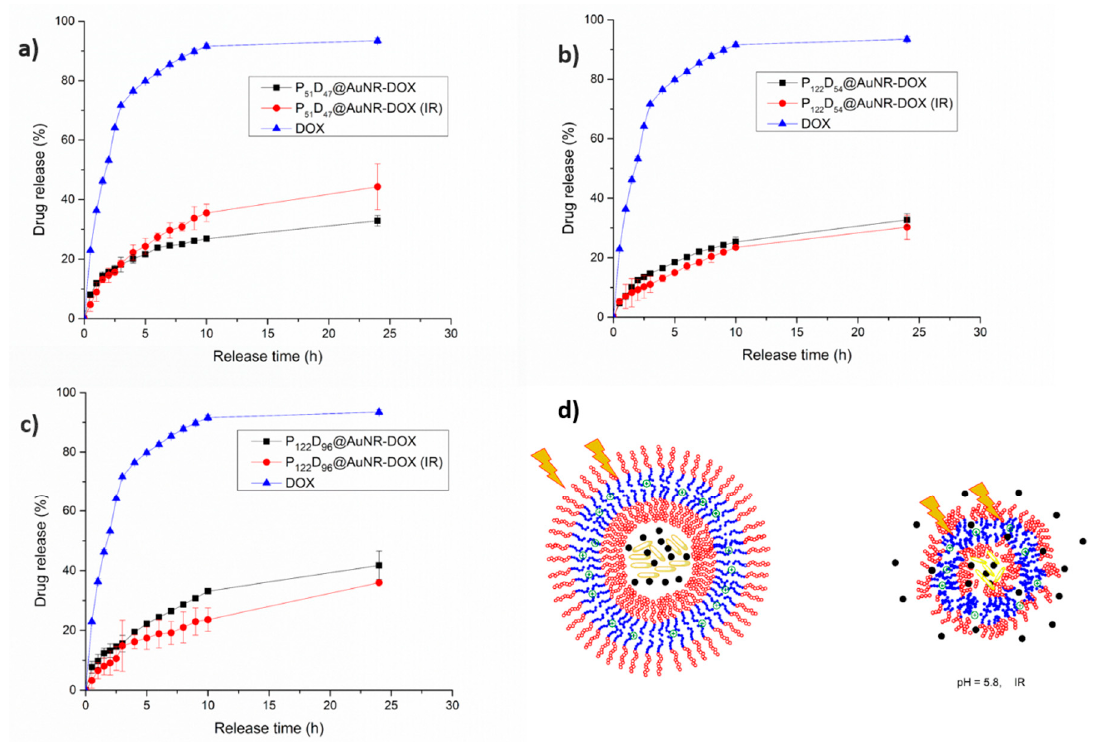
Figure 13. In vitro release profiles for DOX and AuNR-DOX-loaded polymersomes. Effect of NIR irradiation at a pH value of 5.8: ( a ) P 51 D 47 polymersomes, ( b ) P 122 D 54 polymersomes, ( c ) P 122 D 96 polymersomes. ( d ) Model of polymersomes behavior.